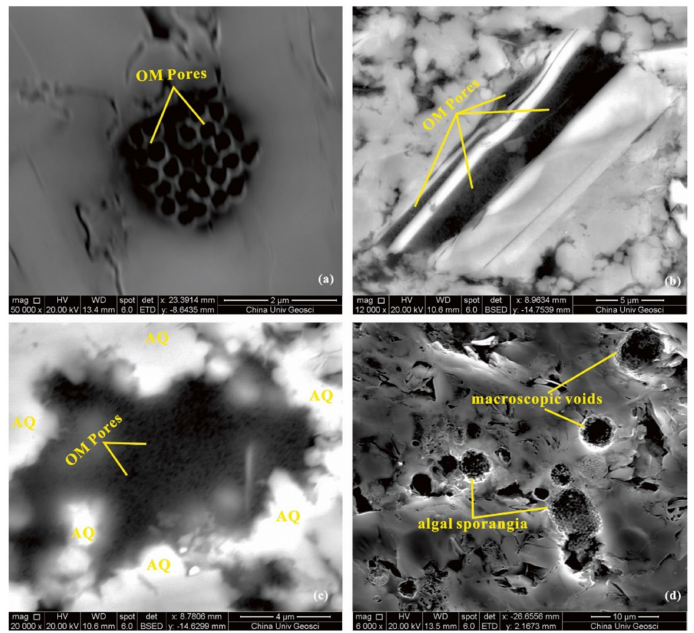
Figure 5. Characteristics of organic pores. ( a ) honeycomb-shaped OM pores; ( b ) OM pores within clay minerals; ( c ) OM pores between microcrystalline quartz (AQ); ( d ) OM pores related to the skeleton structure of organic